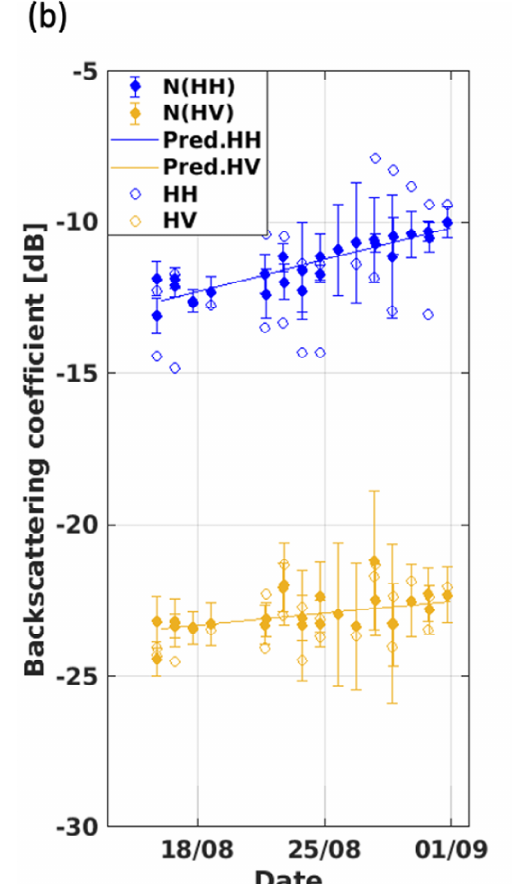
Figure 5. ( a ) Scatterplot of the backscattering coe ffi cients of Sentinel-1 EW data in HH- ( σ 0 HH ) and HV-polarization ( σ 0 HV ) over the multi-year sea ice (MYI) surface with respect to the incidence angle. ( b ) Temporal variation of the incidence angle corrected (N( σ 0 )), predicted, and un-normalized ( σ 0 ) backscattering coe ffi cients.